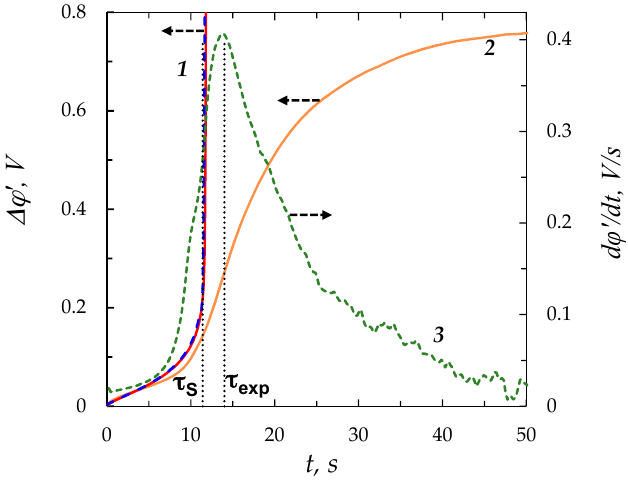
Figure 10. Calculated 1 (“zonal” model—solid red line, “simplified”—dashed blue line) and experimental 2 chronopotentiograms for a MK-40 MOD membrane in a 20 mol/m 3 NaCl solution ( ε = 1.6 × 10 − 10 ) at i/i lim = 1.7. The graphics are plotted as the reduced potential drop ∆ φ ’ = ∆ φ − ∆ φ ohm vs. time (where ∆ φ ohm is the ohmic potential drop in the membrane system measured just after switching on the current); the Sand ( τ s = 11.4 s) and the experimental ( τ exp = 14 s) transition times are shown with vertical dotted lines; curve 3 presents the experimental values of d ∆ φ ’ /dt . The experimental data are taken from Reference [37].